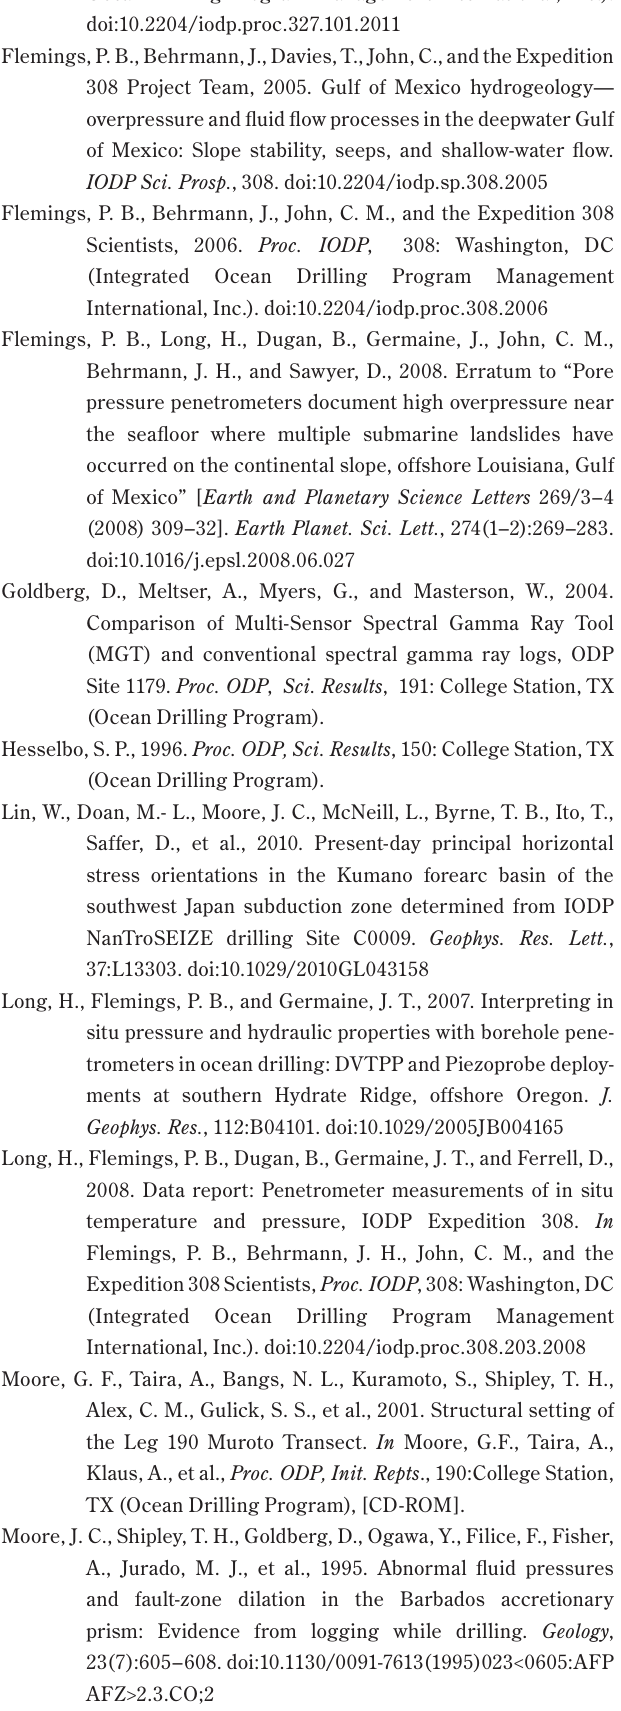
Fig. 2a−c: Peter Flemings, The Unicersity of Texas at Austin Fig. 2d: William Crawford,